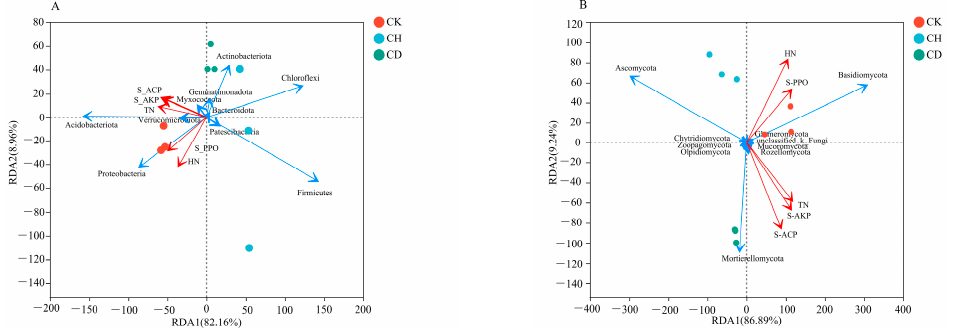
Figure 11. Correlations between bacterial and fungal phyla, soil physicochemical properties, and enzyme activities. ( A ) Results of the redundancy analysis (RDA) of the top 10 bacterial phyla, soil physicochemical properties, and soil enzyme activities. ( B ) Results of the RDA of the top 10 fungal phyla, soil physicochemical properties, and soil enzyme activities. CH—biennial ginseng seedlings that were transplanted and then continuously cropped for four years in healthy ginseng rhizosphere woodland soil, CD—biennial ginseng seedlings that were transplanted and then continuously cropped for four years with severe soilborne disease in ginseng rhizosphere woodland soil, CK—soil sample from woodland without ginseng planting. TN—total nitrogen, HN—hydrolyzable nitrogen, S-ACP—soil acid phosphatase activity, S-AKP—soil alkaline phosphatase activity, and S-PPO—soil polyphenol oxidase activity.